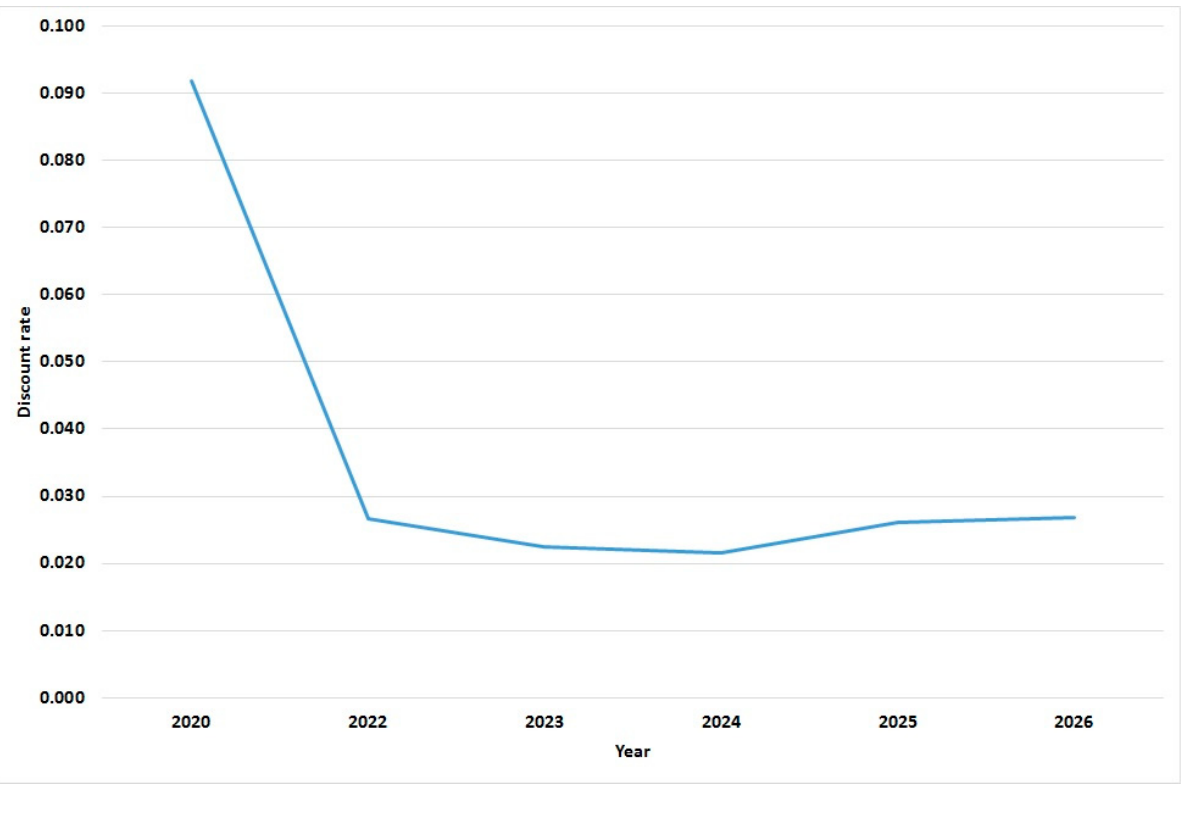
Table 11. Net Present Value calculation (€).